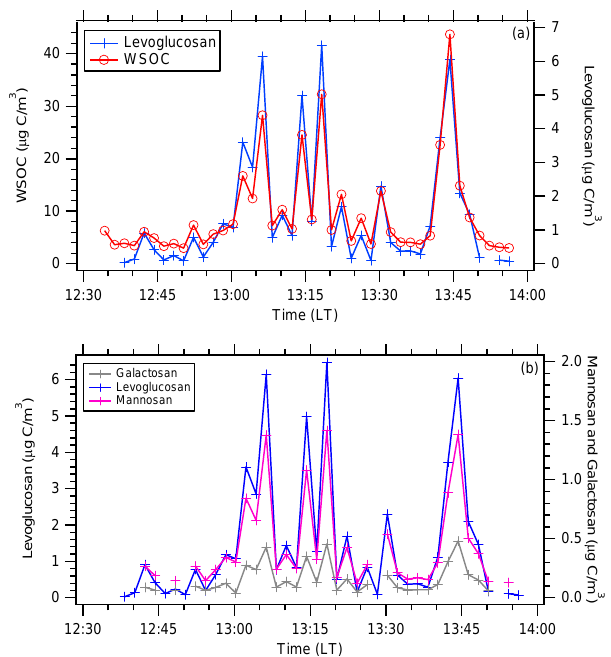
Figure 3. Times series of 2min absolute (a) levoglucosan and WSOC and (b) galactosan, levoglucosan, and mannosan from